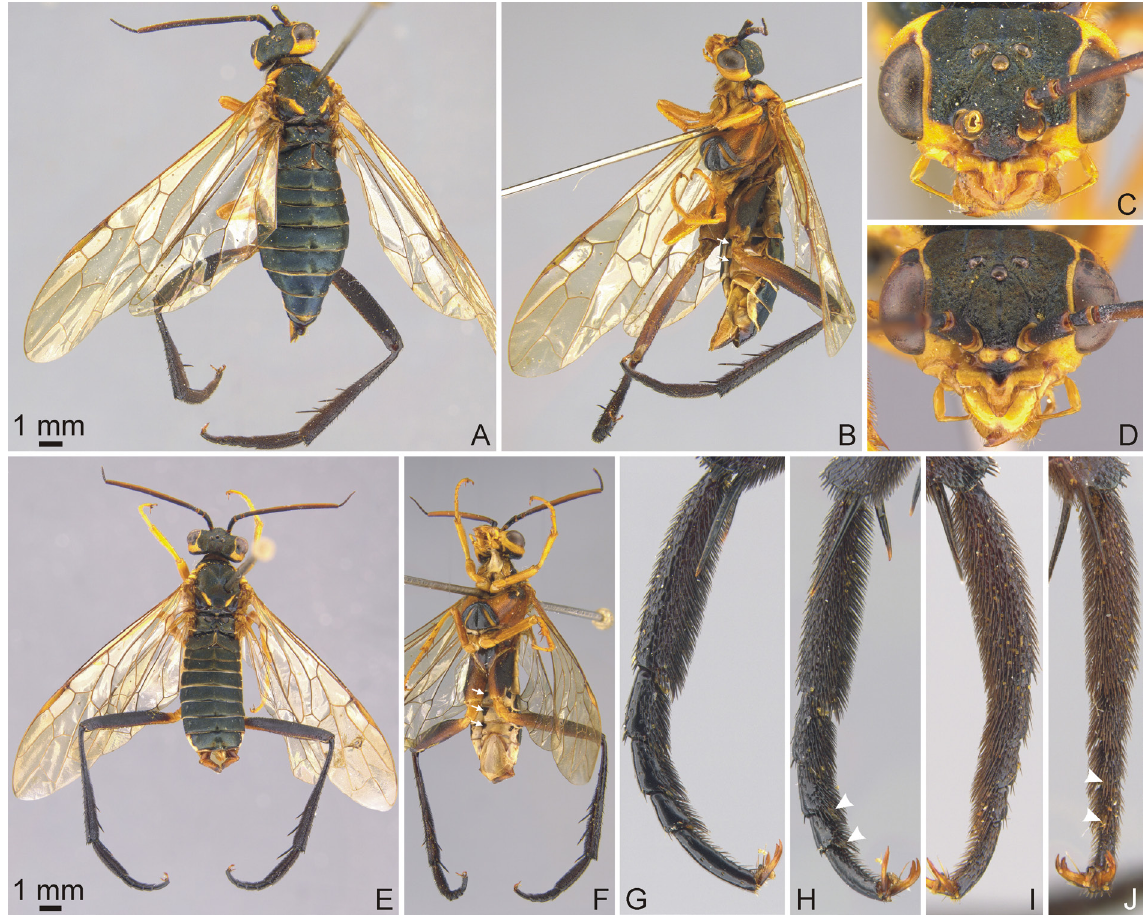
Fig. 10. Megaxyela togashii Shinohara, 1992, ♀, holotype, DEI-GISHym 22352 (NSMT); ♂, 22354, (NSMT). A–B . Habitus dorsal/lateroventral (♀). C . Head frontal (♀). D–E . Habitus dorsal/lateroventral (♂). F . Head frontal (♂). G–H . Metatarsus lateral/ventral (♀). I–J. Metatarsus lateral/ventral (♂). Arrows in Fig. 10B and 10F indicate dark spots of abdominal sterna, arrowheads in H and J indicate minute